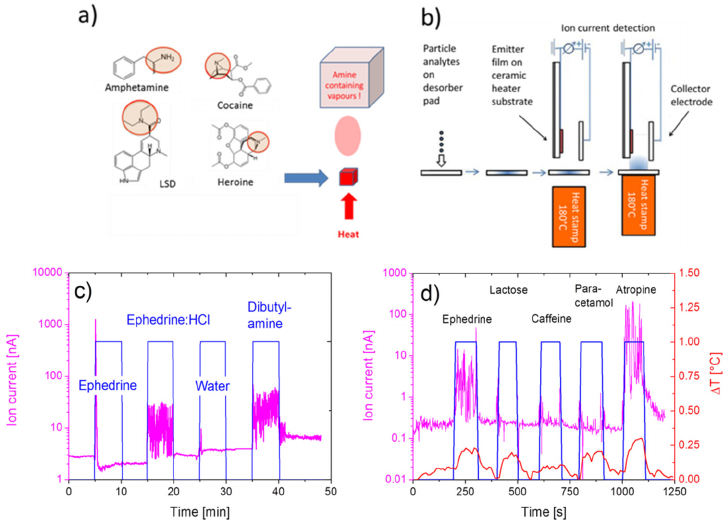
Figure 17. ( a ) Thermal disintegration of illicit drugs yielding hydrocarbon fragments with amine functional groups (circles); ( b ) process of collection and thermal desorption of analytes into the air gap of an SI detector; ( c ) SI current response to the evaporation of the drug substitutes ephedrine and ephedrine:HCl. For comparison, the responses to pure solvent water and to an organic decay product (dibutylamine) are shown [49]; ( d ) response to the evaporation of ephedrine and a range of cutting agents (lactose, caffeine, paracetamol, atropine), which usually contaminate street samples of illicit drugs [50,53–56]. The red line in ( d ) mirrors the temperature rise of the SI emitter film when the substance is evaporated into the air gap of the SI